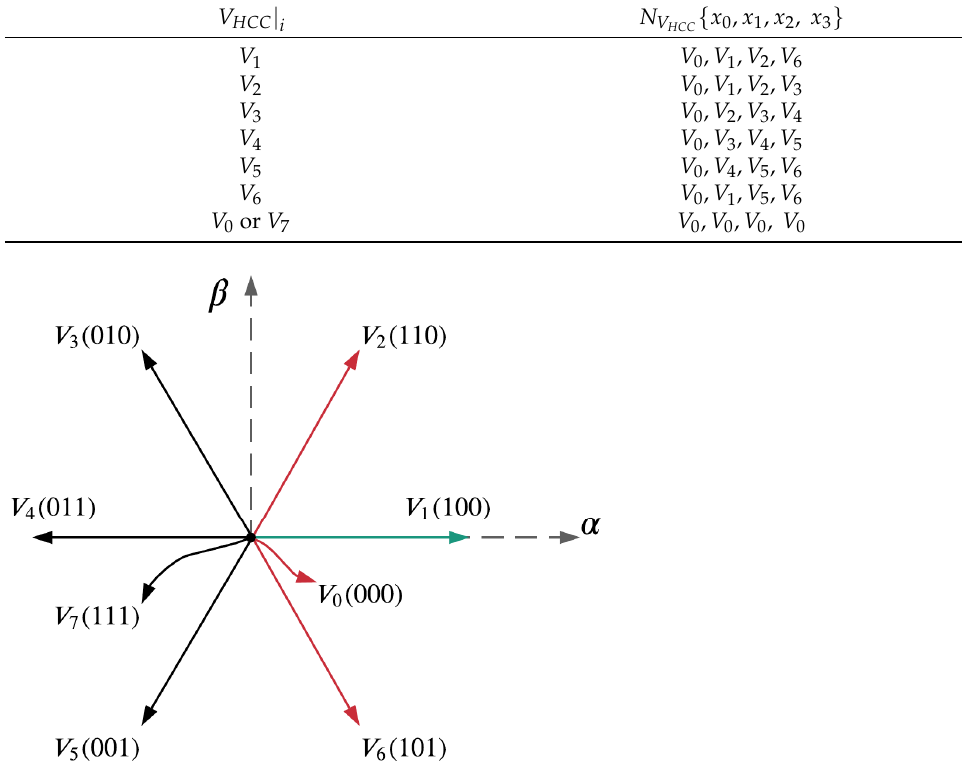
Figure 2. Block diagram of the HCC–MPCC.